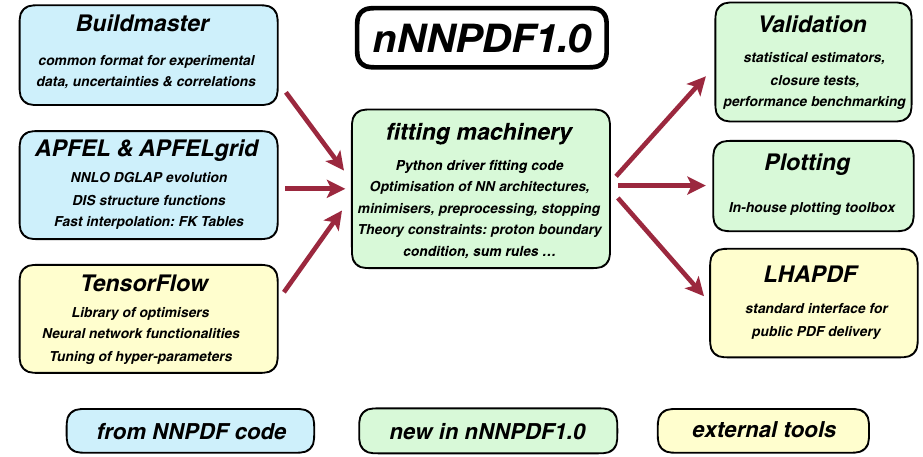
APFELgridBuildmaster APFEL &